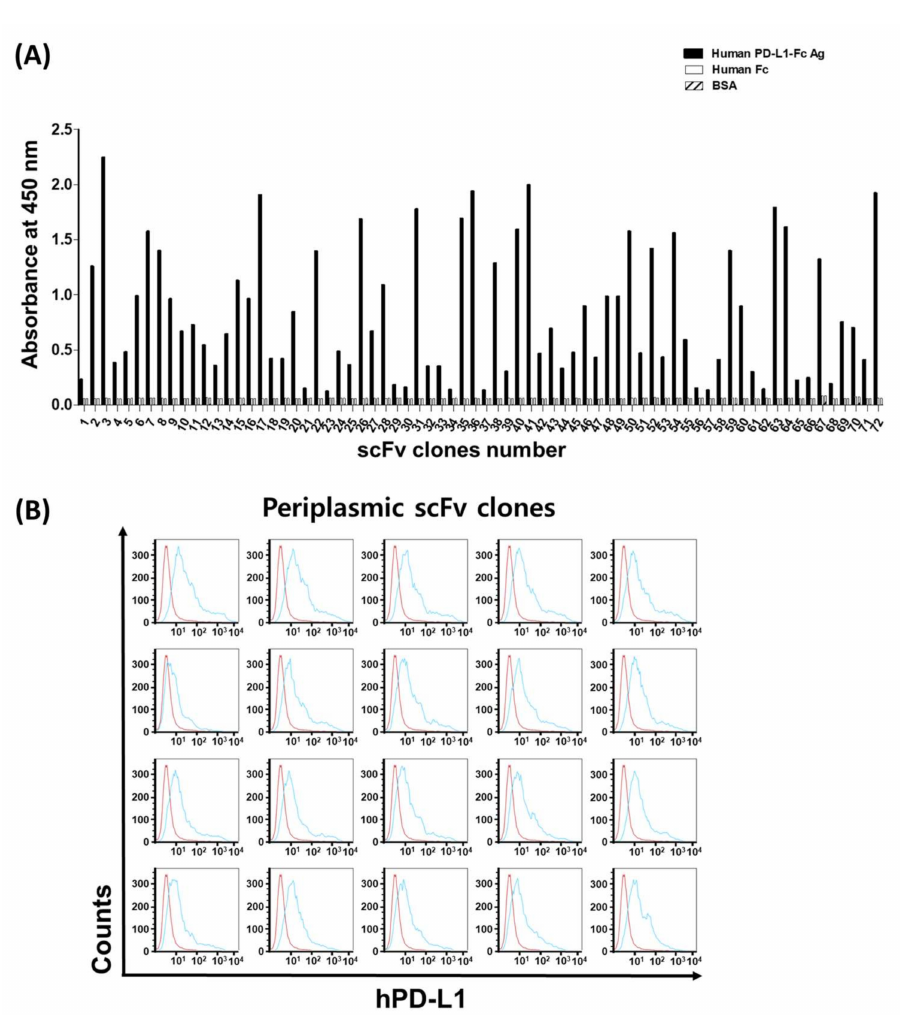
Figure 1. Isolation of scFv clones specific to human PD-L1s. ( A ) The individual specific binders are screened by ELISA and 72 different scFv clones were further characterized by sequencing. Reactivity of the selected scFv clones to human PD-L1 was assayed by measuring absorbance at 450 nm. The individual scFv clones were reactive to hPD-L1-Fc ( ■ ), but not hFc (□) or BSA ( ▨ ); ( B ) Binding activity of scFv (top 20 clones) on hPD-L1 293T cells measured using flow cytometry. 293T cells were transfected with human PD-L1s. Binding of periplasmic scFvs was detected by adding first anti-c- Myc murine monoclonal antibody followed by Alexa Flour 488-conjugated antimurine IgG